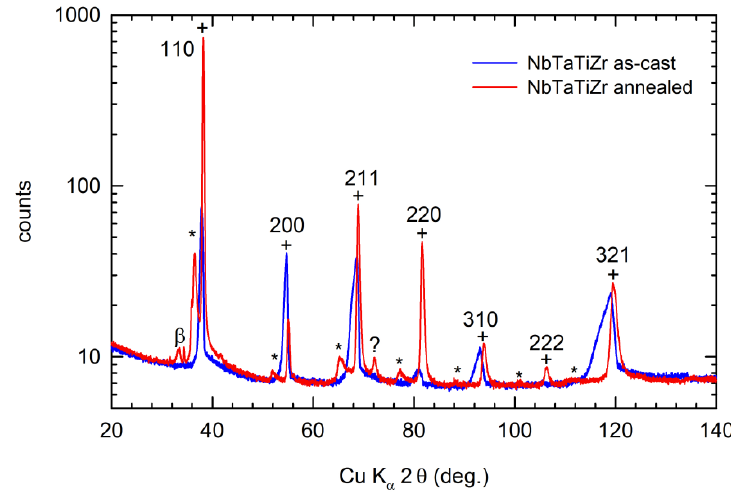
Figure 3. XRD patterns of NbTaTiZr alloy in the as-cast state and after annealing at 1200 °C. Reflections for Ti, Zr-rich and Nb, Ta-rich bcc phases are denoted by stars and crosses, respectively. The label β denotes reflection arising from the Cu K β wavelength. The origin of the peak denoted by the ? label is unknown.